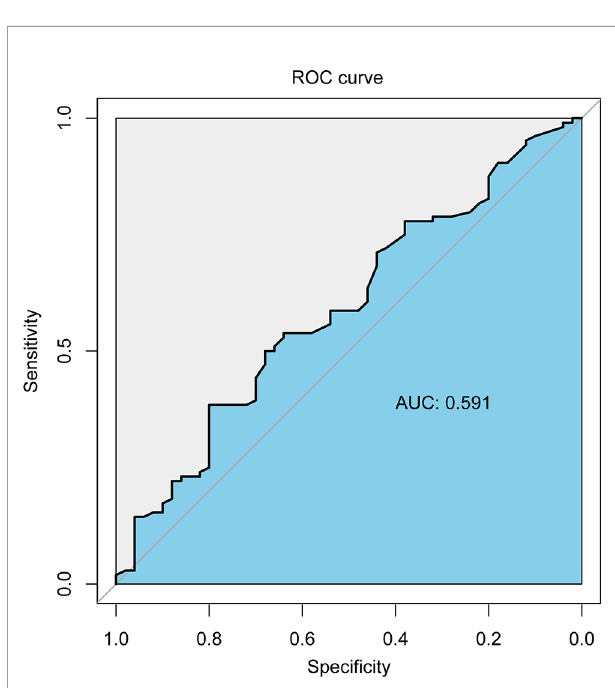
FIGURE 2 | The receiver operating characteristic curve of the follow-up interval for predicting ORR of all